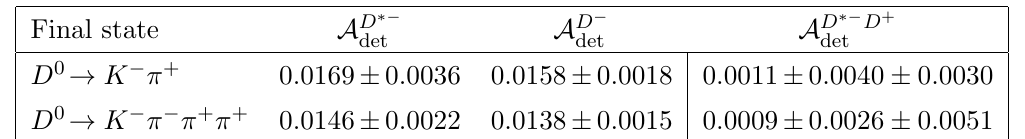
Table 3 . Instrumental asymmetries of D (cid:6) , D (cid:3)(cid:6) and their combination for B 0 obtained from prompt D meson decays. The quoted uncertainties are statistical, in the last column statistical and